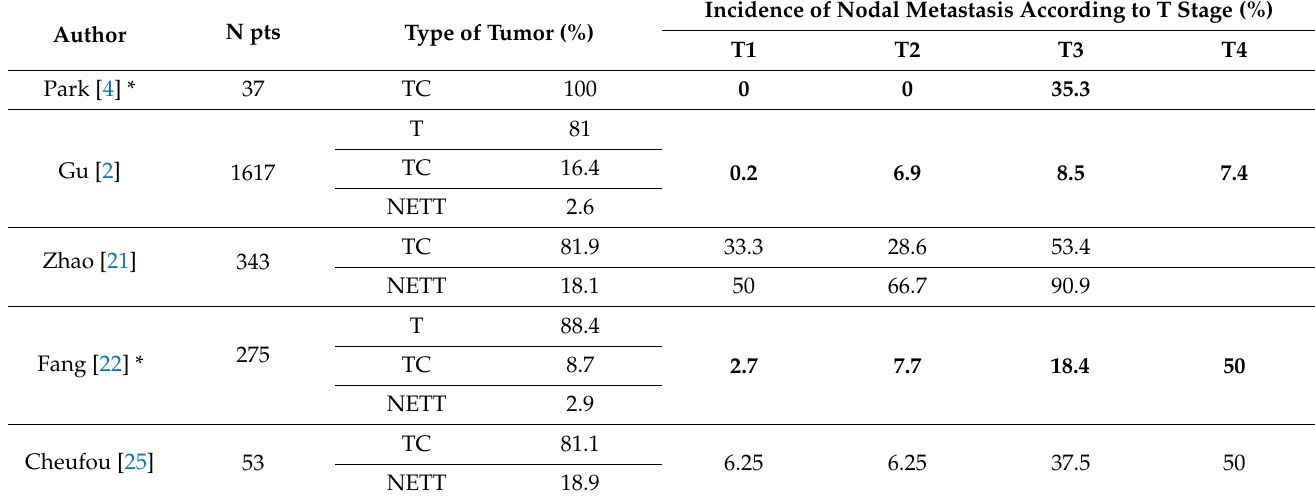
Table 3. Studies comparing the incidence of lymph node metastasis in thymic tumors according to the T-stage over the last 20 years. Difference of values in bold is statistically